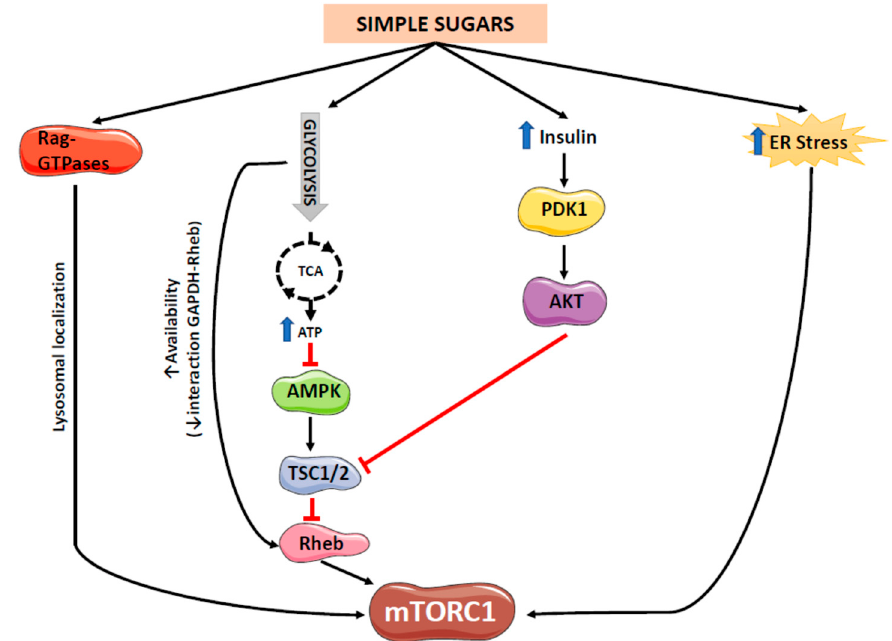
Figure 2. Proposed mechanisms of mTORC1 activity regulation by simple sugars. mTORC1 activation by simple sugars might be mediated by several mechanisms, including (i) Rag-GTPases activation, which cause mTORC1 lysosomal localization, (ii) increased glycolytic flux, which might increase Rheb availability and inhibit AMPK activity, (iii) increased plasma insulin levels and (iv) increased ER stress.